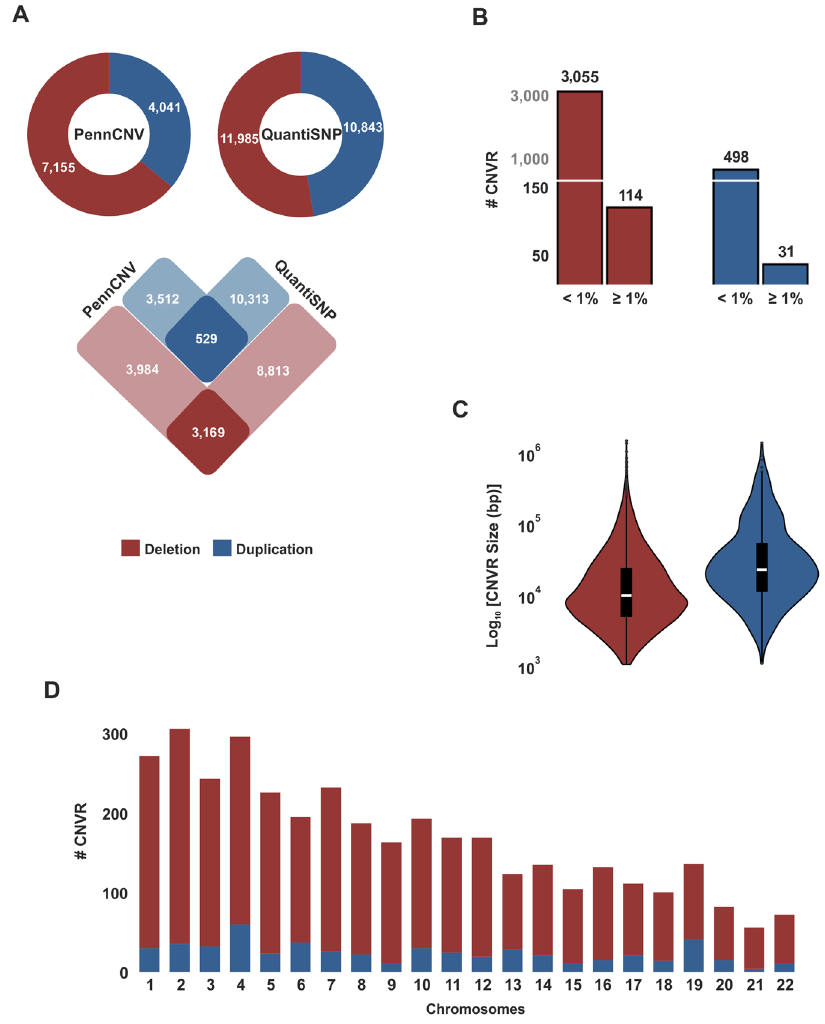
Figure 1. Copy number variation regions (CNVRs) detected in the genome of children from Salvador, Brazil. Copy number variations in the genome of 872 individuals from the SCAALA-Salvador cohort were inferred from SNP microarray data (Illumina HumanOmni 2.5–8v1 panel), using algorithms implemented in PennCNV v1.0.1 and QuantiSNP v2.0. Deletions or duplications showing sequence overlap were grouped into a single CNVR. ( A ) Number (#) of CNVRs detected by PennCNV and QuantiSNP (after quality control). Only CNVRs detected by both algorithms were considered for further analysis. ( B ) Frequency of deletions and duplications ( < 1% or ≥ 1%) in the study population. ( C ) Size of the deletions and duplications (bp, base pair), violin plots. ( D ) Number (#) of CNVRs by human autosomal